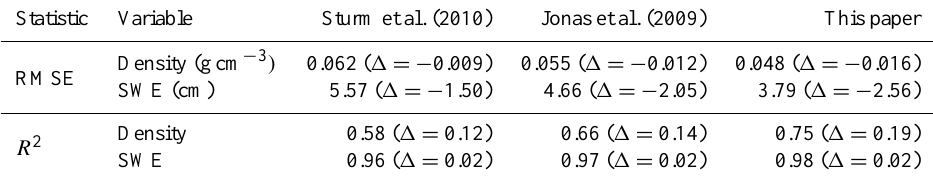
Fig. 9. The distribution of model parameters over all SNOTEL sites. If the parameter is the coefficient of a predictor, the predictor name is shown in parentheses. Otherwise the parameter name is given. Top panel is the Sturm model, middle panel is the Jonas model, and the bottom panel is the model developed in this paper. Table 3. Model statistics of fit (not under parameter transfer). Improvements compared to parameter transfer statistics are indicated by 1